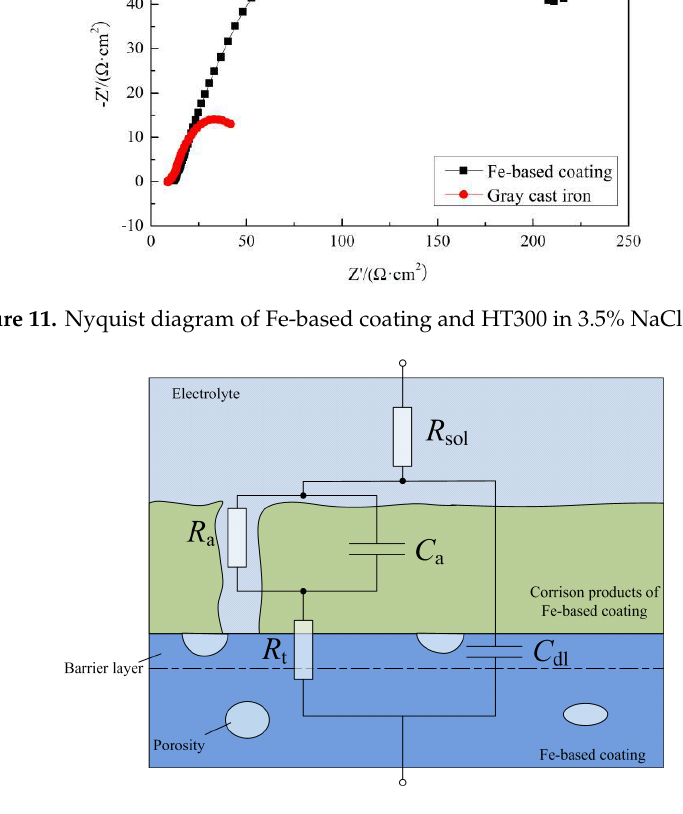
Figure 12. Equivalent circuit diagram of the coating. Table 4. Electrochemical impedance spectroscopy parameters of Fe-based coating and HT 300 in 3.5% NaCl